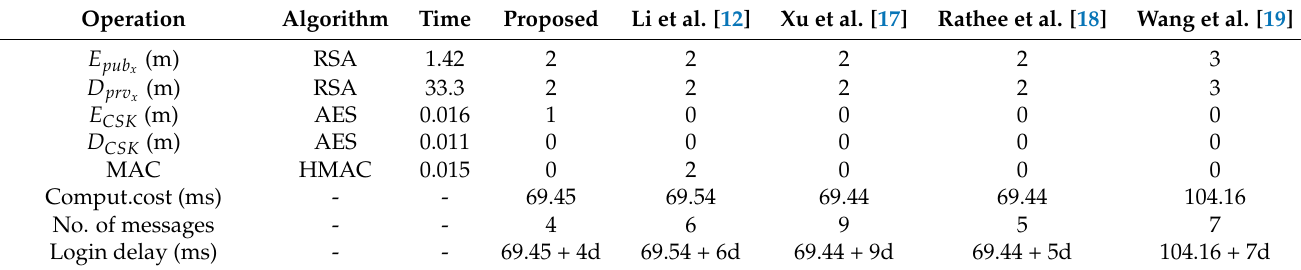
Table 3. Simulation results during login process.